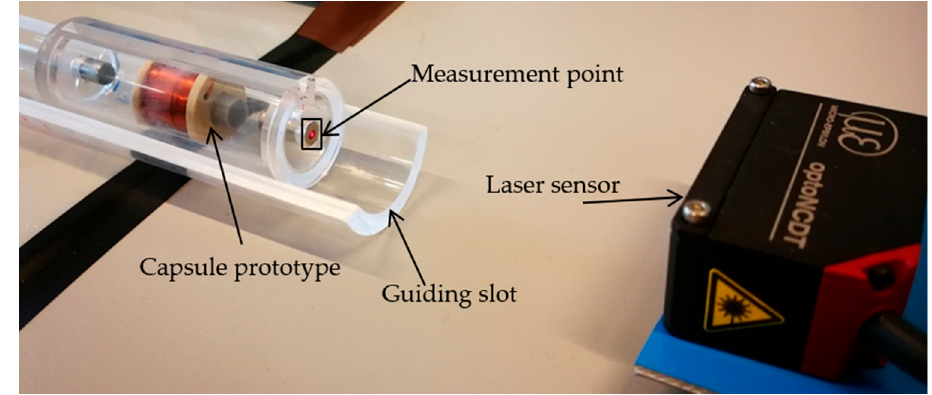
Figure 7. Experimental setup.